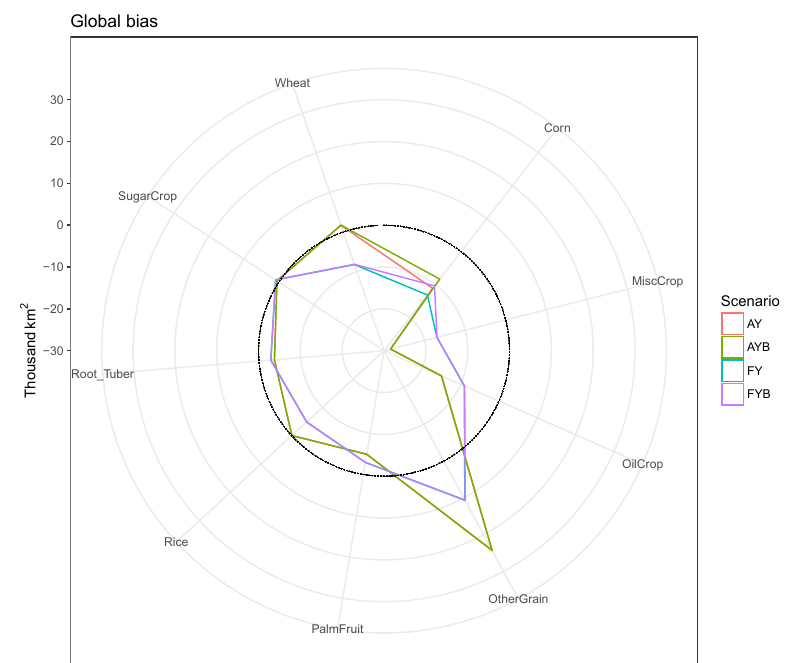
Figure 1. Global bias, b i G (Eq. 5). The black circle corresponds to b i,G =